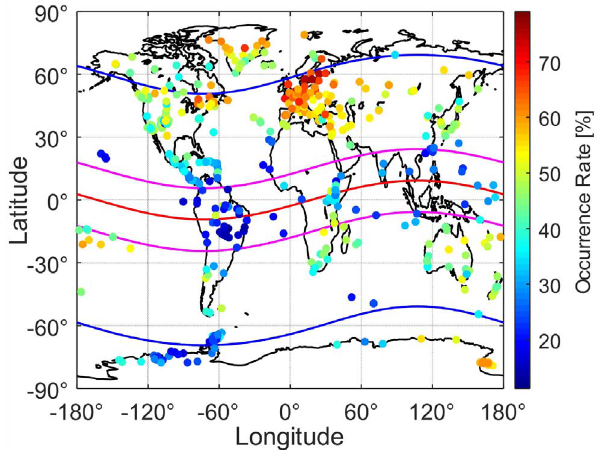
Figure 3. The occurrence rate of the DDM phenomenon observed at each station during 2019 – 2020. In the fi gure, the solid red line represents the magnetic equator, the solid magenta line represents the MLAT ±15 (cid:1) , and the solid blue line represents the MLAT ±60 (cid:1)